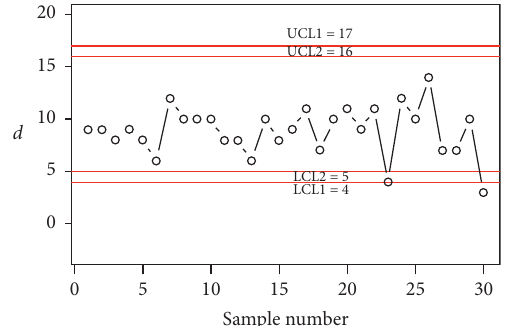
Figure 6: The Birnbaum–Saunders chart using the MDSS method for the coupon data.